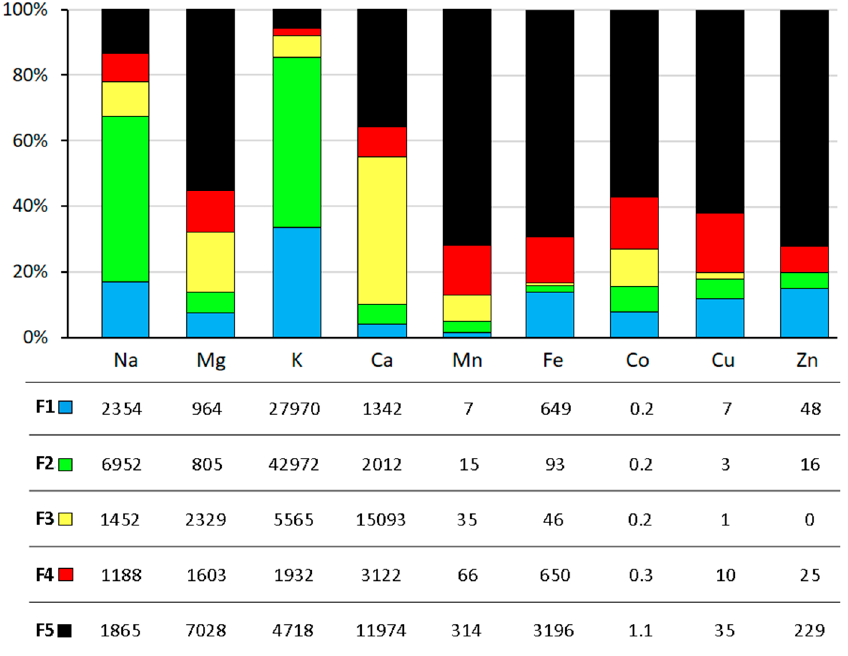
Figure 2. The sequential extraction allowed to reveal the water soluble (F1), exchangeable (F2), carbonate-bound (F3), sulfide bound (F4), and residual (F5) fractions of trace elements (TEs) present in the original buffalo manure–cheese whey digestate used as inoculum in the biochemical methane potential (BMP) tests. All values are expressed as µg TE/g TS.